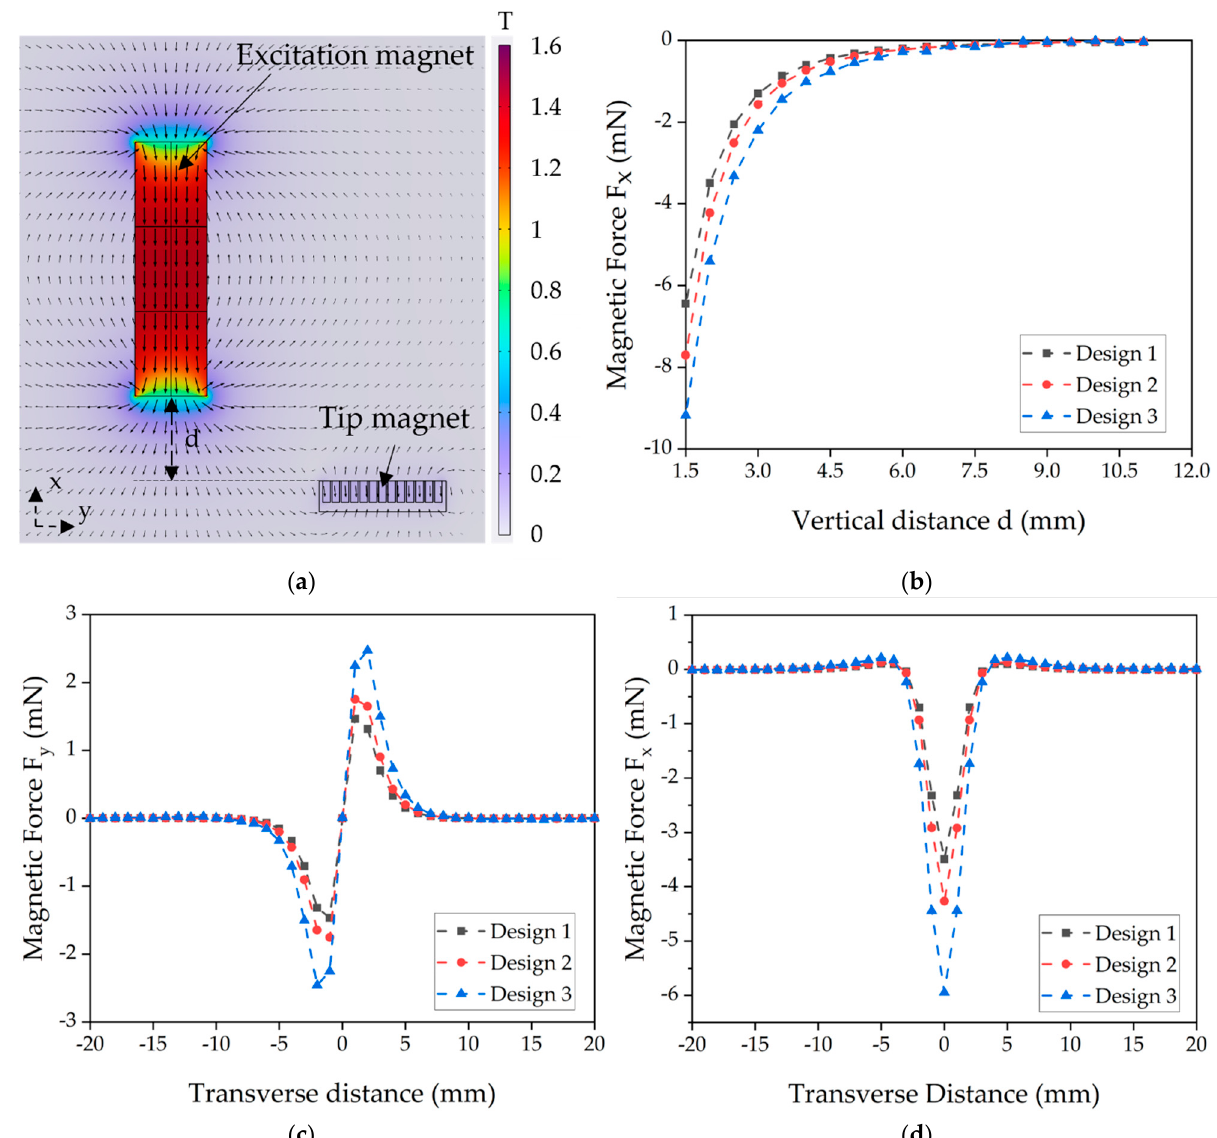
Figure 14. Magnetostatic FEM simulations. ( a ) Magnetic flux density distribution of a design 3 magnet and an excitation magnet. ( b ) Simulated vertical magnetic forces F x for different distances between harvester and excitation magnet. ( c ) Transverse force F y and ( d ) vertical force F x during movement of the tip magnet in vertical direction with constant vertical distance of d = 2 mm.